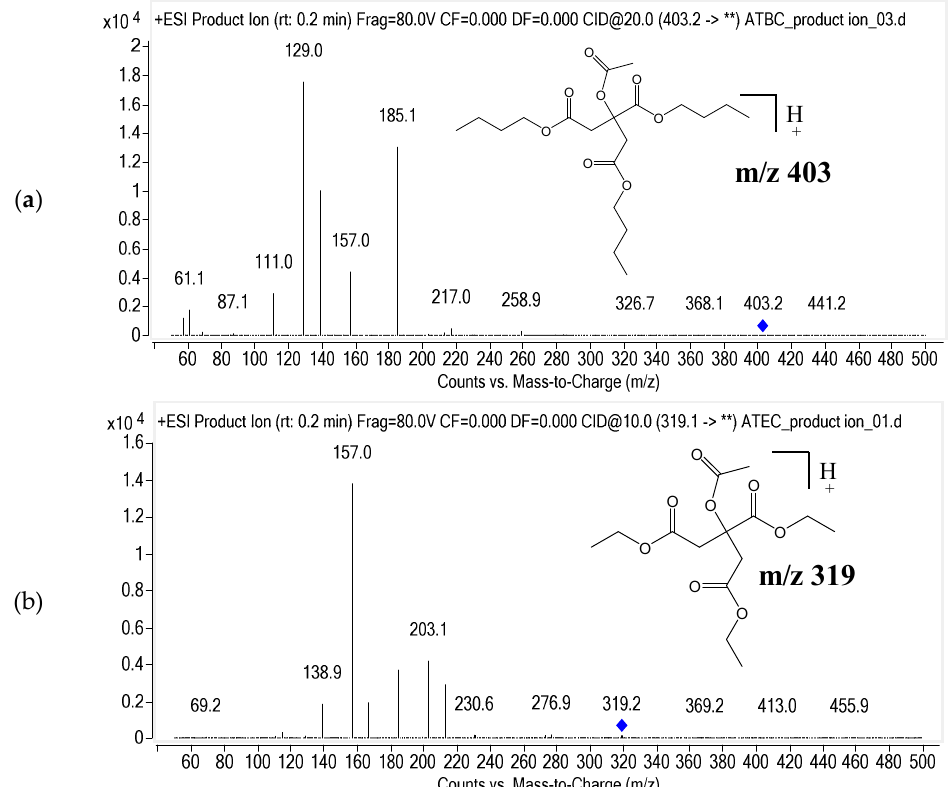
Figure 1. Product ion mass spectrum of ( a ) Acetyl tributyl citrate (ATBC) and ( b ) Internal standard (IS) (ATEC, acetyl triethyl citrate).